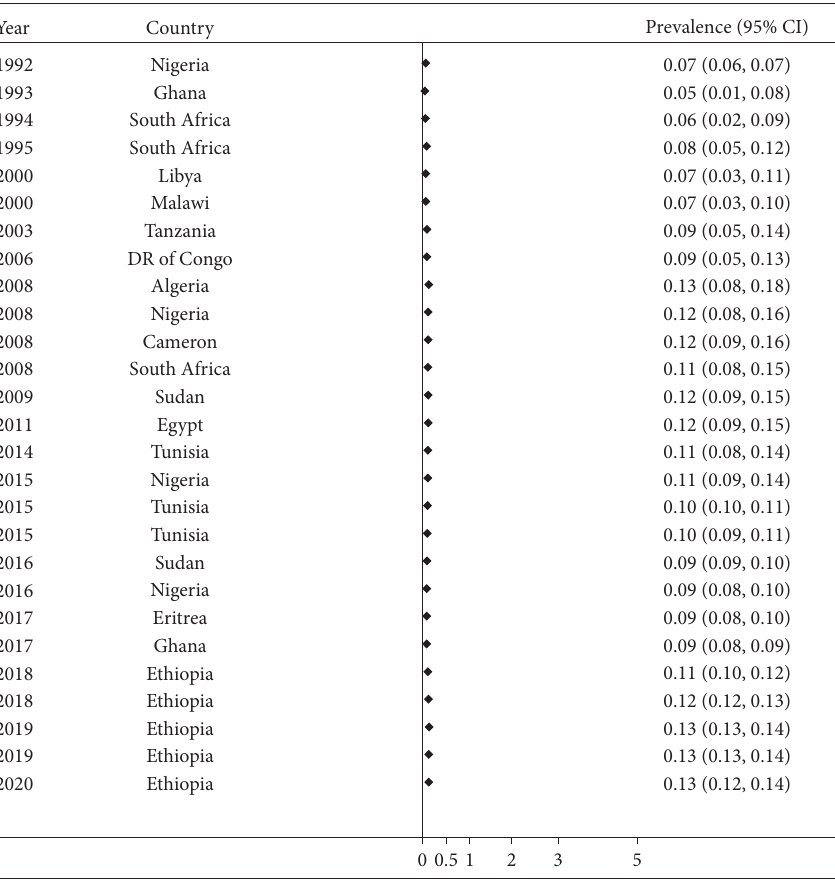
Figure 6: Meta-cumulative analysis of the prevalence of spina bifida in Africa, 2020.